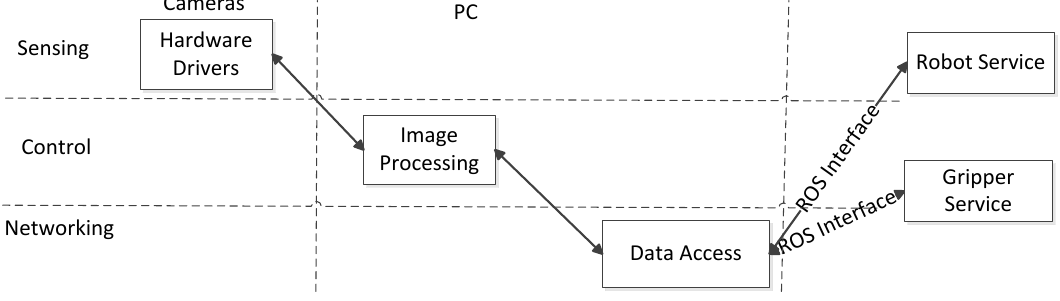
Figure 5. Vision agent architecture.